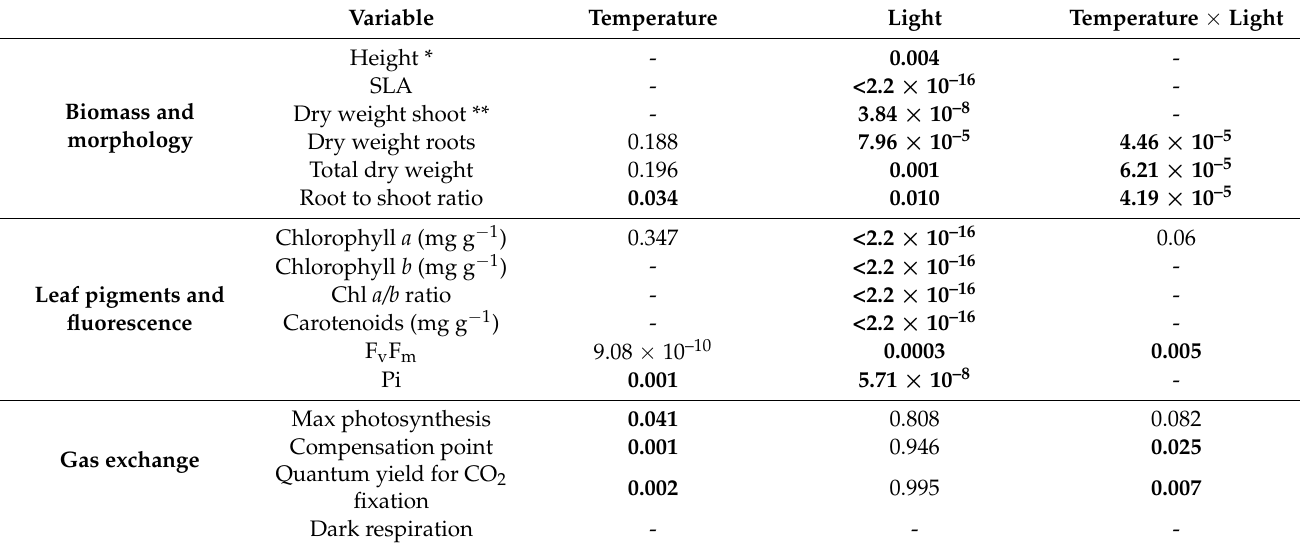
Table 1. p -values of the two-way ANOVA excluding the field trial and considering different treatments as a fixed factor and species as random effect. Bold numbers corresponded to significant values ( α =